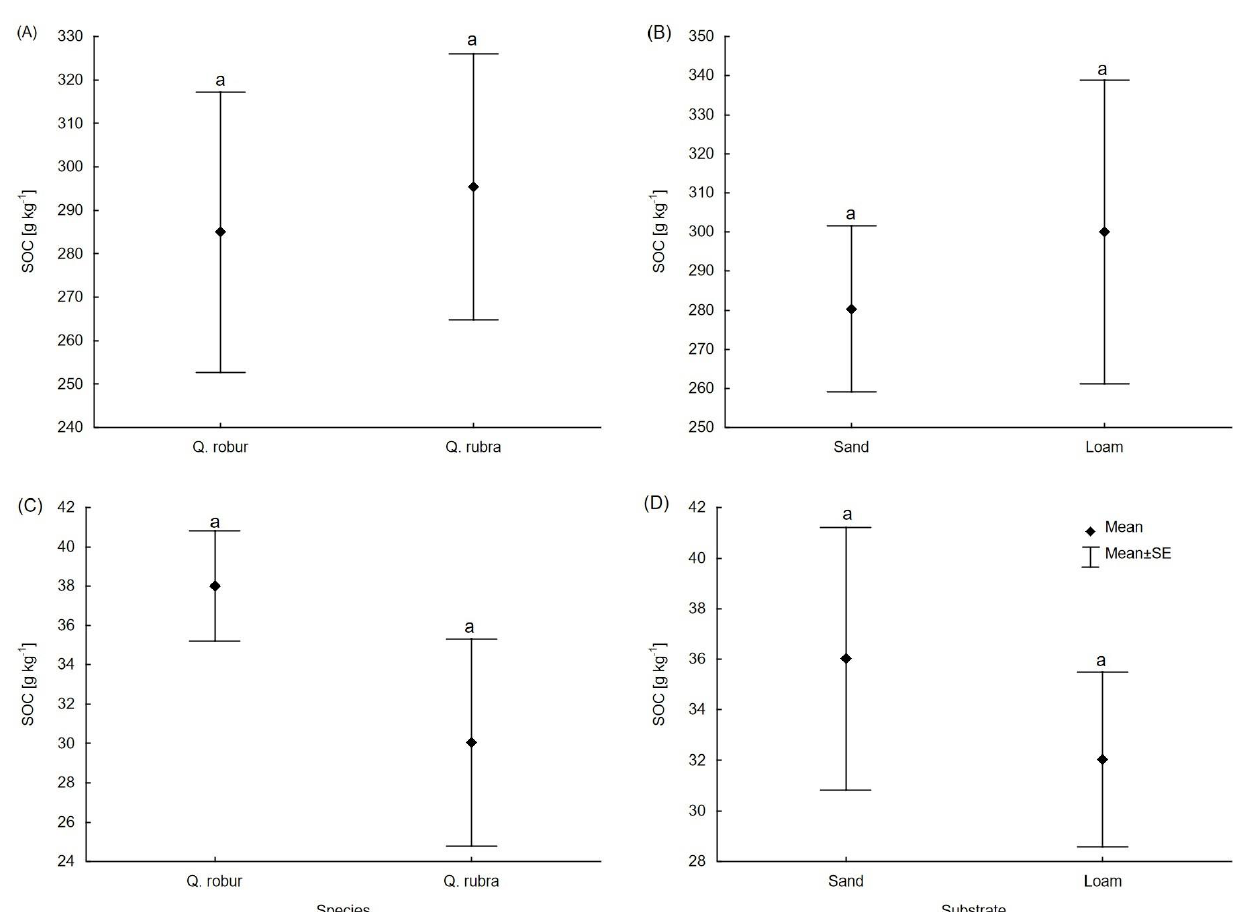
Figure 1. SOC content in litter Oi + Oe ( A , B ) and 0–5 cm mineral ( C , D ) horizons under common and red oak stands on studied post-fire site; means followed by the same lowercase (a) are not significantly different at p <